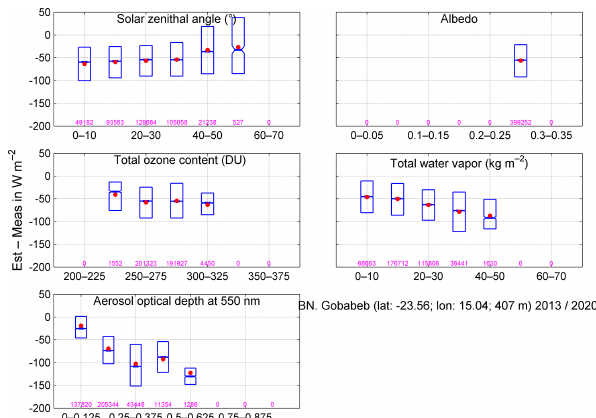
Figure 5. Box plots of the differences between the McClear esti- mates and the measurements of B N at the BSRN station Gobabeb (no. 28, climate BWh) for several classes of various variables. In each box plot, the red point is the mean, while the lower, middle, and upper lines are respectively the 25th, 50th, and 75 percentiles. The number of samples is given for each class. Only classes with at least 50 samples are